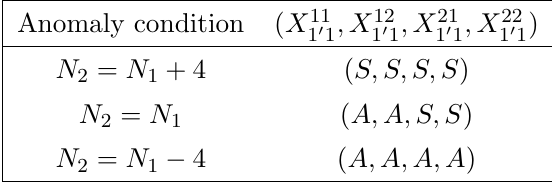
, all of them with gauge 2